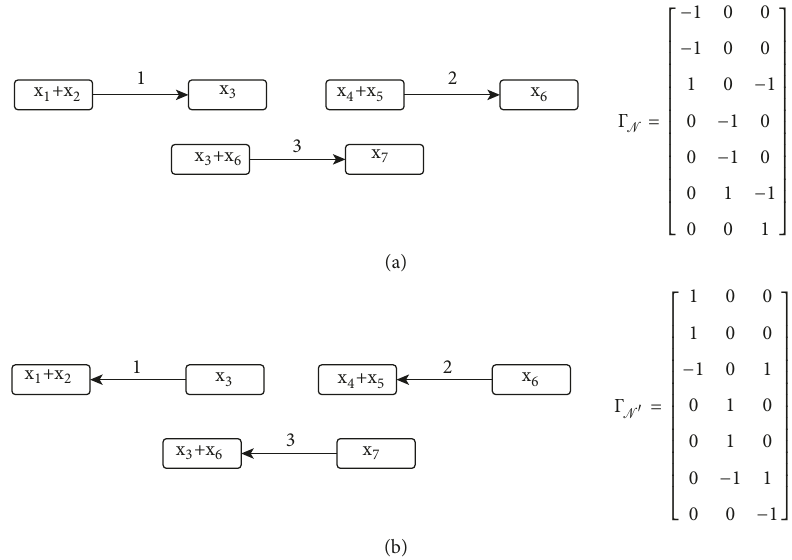
Figure 2: A pair of sub- and superconservative reaction network structures denoted by N and N 󸀠 , respectively. The ordering of the reactions are denoted by the numbers on the edges of the graphs. The two networks can be transformed to each other by changing the sign of the entries in their stoichiometric matrices. (a) Subconservative d-CRN. (b) Superconservative